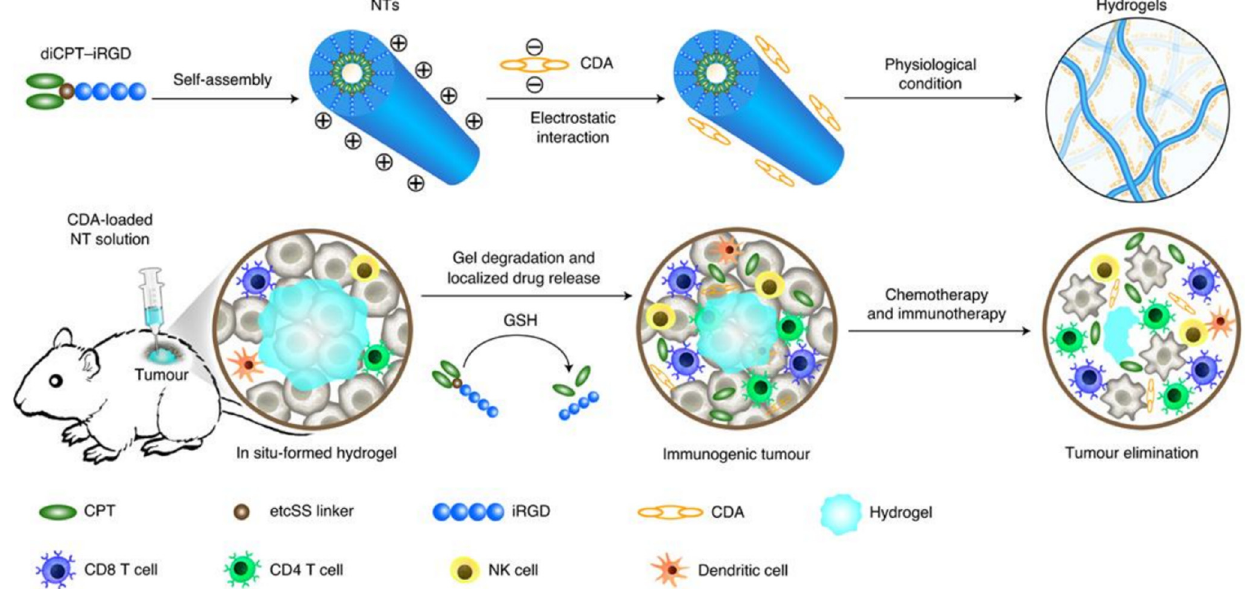
Figure 8. Principle and working mechanism of the self-assembling therapeutic peptide diCPT-iRGD. The resulting hydrogel releases camptothecin (CPT) when reacting with glutathione (GSH) and releases c-di-AMP (CDA) as the hydrogel degrades. This stimulates the STING pathway and leads to the infiltration of activated immune cells, thus leading to the elimination of cancerous cells. The figure has been reproduced with permission from Springer Nature [113].